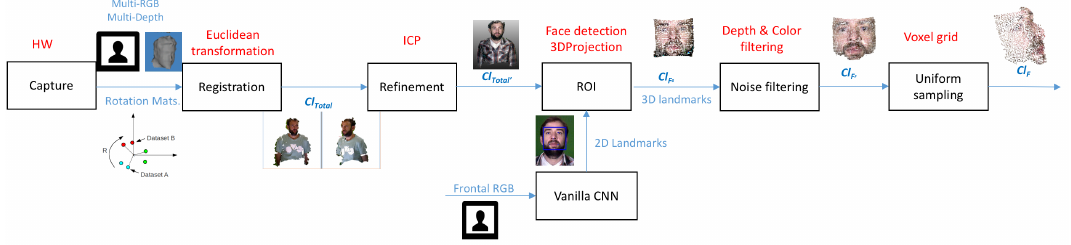
Figure 4. Block diagram of the different steps involved in 3D reconstruction of